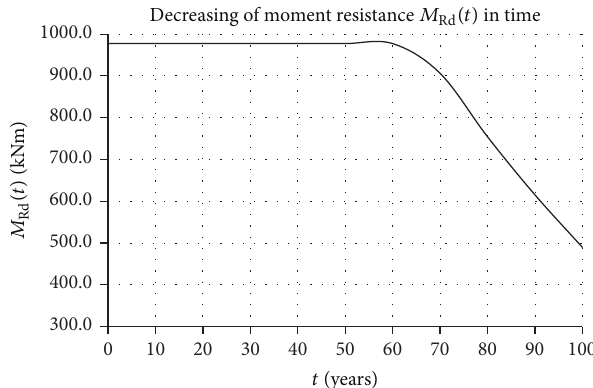
Decreasing of moment resistance M Rd (t) in time